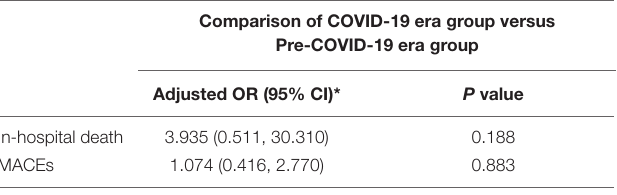
TABLE 4 | Multivariate logistic regression